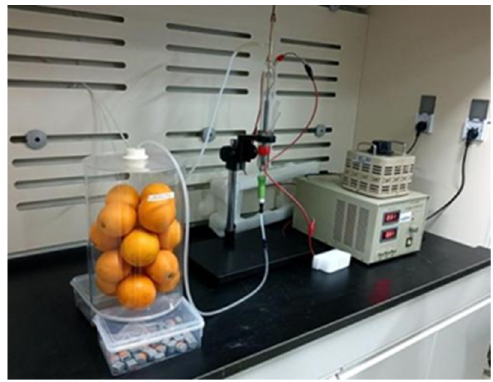
Figure 1. Low-temperature plasma produced by air and oxygen